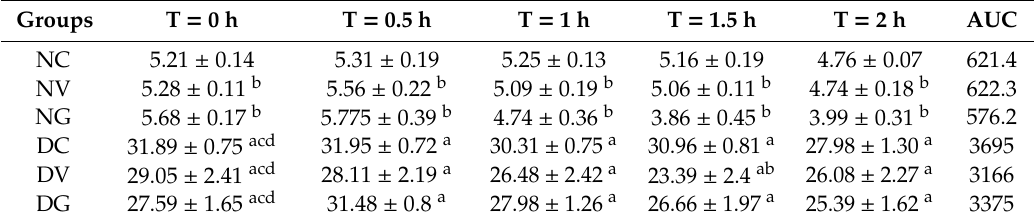
Table 1. Effect of vindoline in nondiabetic and diabetic rats on 2-h oral glucose tolerance test.